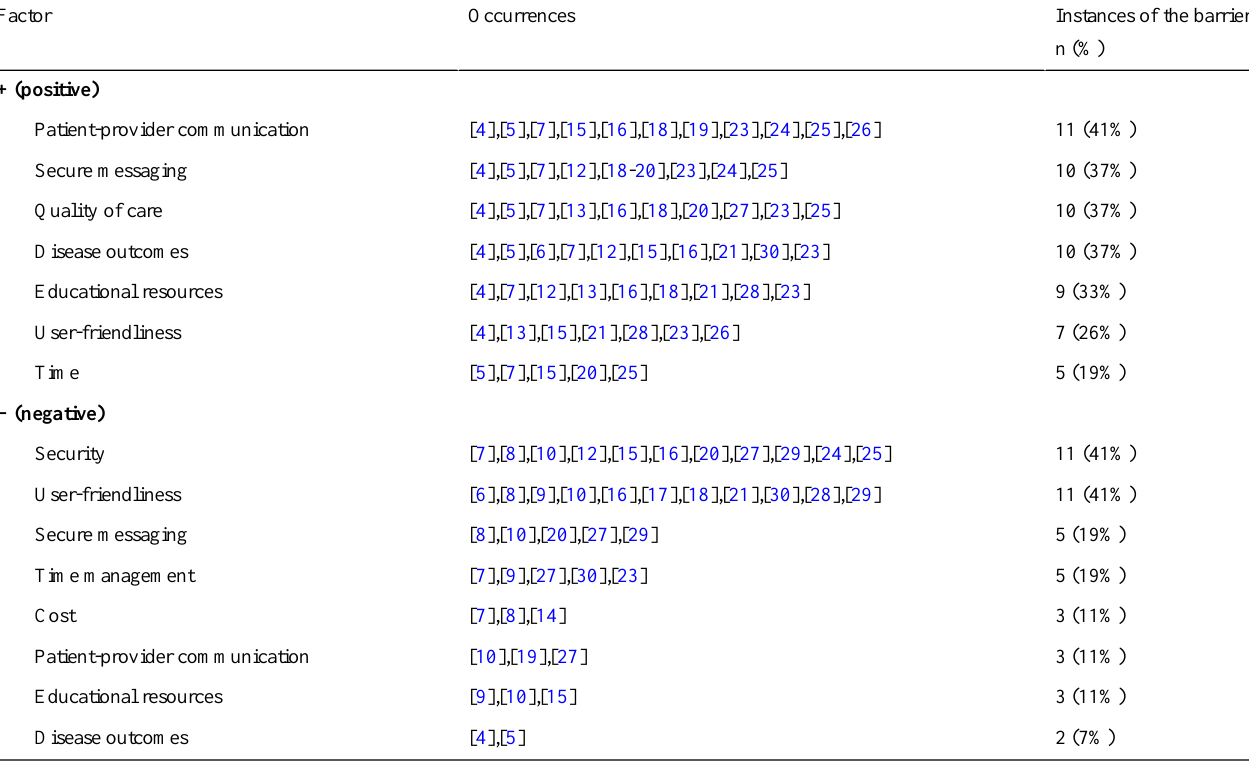
Table 2. Affinity matrix illustrating the frequency of factors identified in the literature